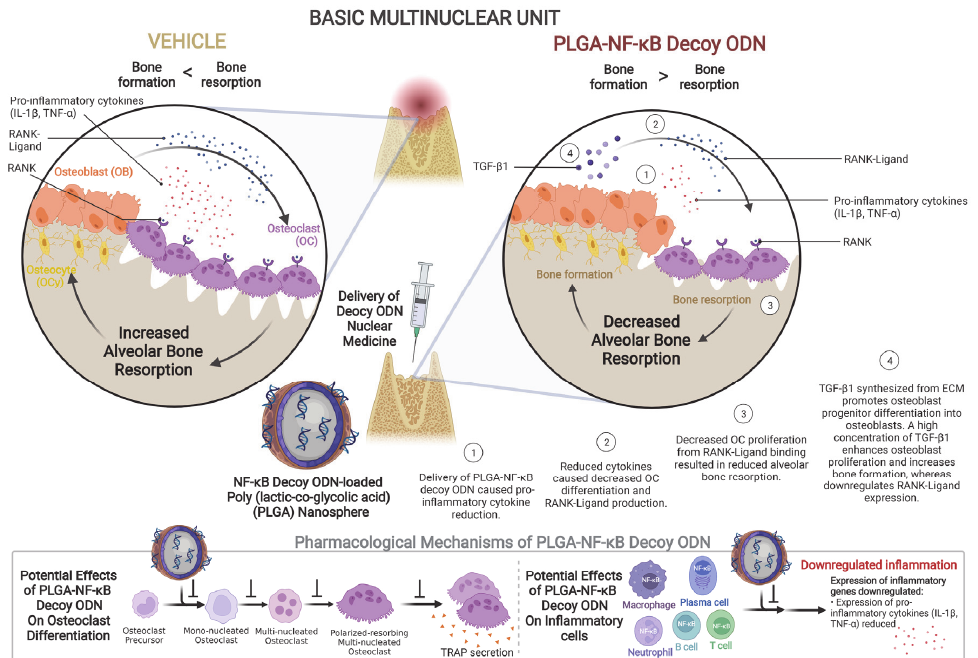
Figure 6. Schematic illustration of the effect of PLGA-NfD on osteoclast differentiation and inflam- matory cells, including neutrophils, T- and B-lymphocytes, plasma cells, and macrophages on the extraction-socket tissue. PLGA-NfD demonstrates the usefulness of the PLGA nanospheres for NF- κ B decoy ODN transfection into the extraction socket under inflammatory healing conditions. Local administration of PLGA-NfD has the clinical potential to prevent dimensional loss at the healing extraction socket and thereby allowing predictable prosthetic rehabilitation. Abbreviations: NF- κ B, nuclear factor-kappa B; ODN, oligodeoxynucleotide; PLGA, poly(lactic-co-glycolic acid); PLGA-NfD, NF- κ B decoy ODN-loaded PLGA